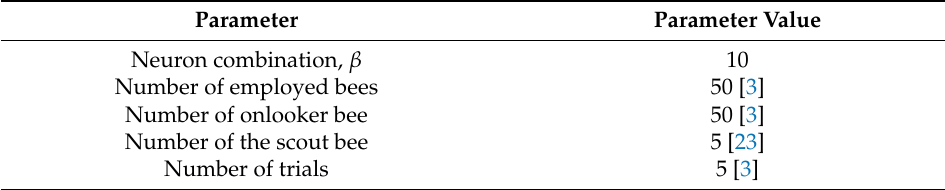
Table 3. List of ABC parameters used in Logic Phase.